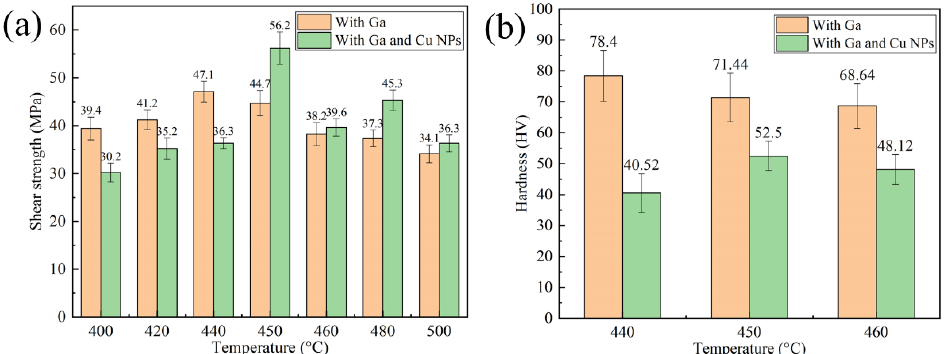
Figure 10. Mechanical properties of the joint bonded at different temperatures: ( a ) Shear strength of joints; ( b ) Hardness of the joints. joints; ( b ) Hardness of the